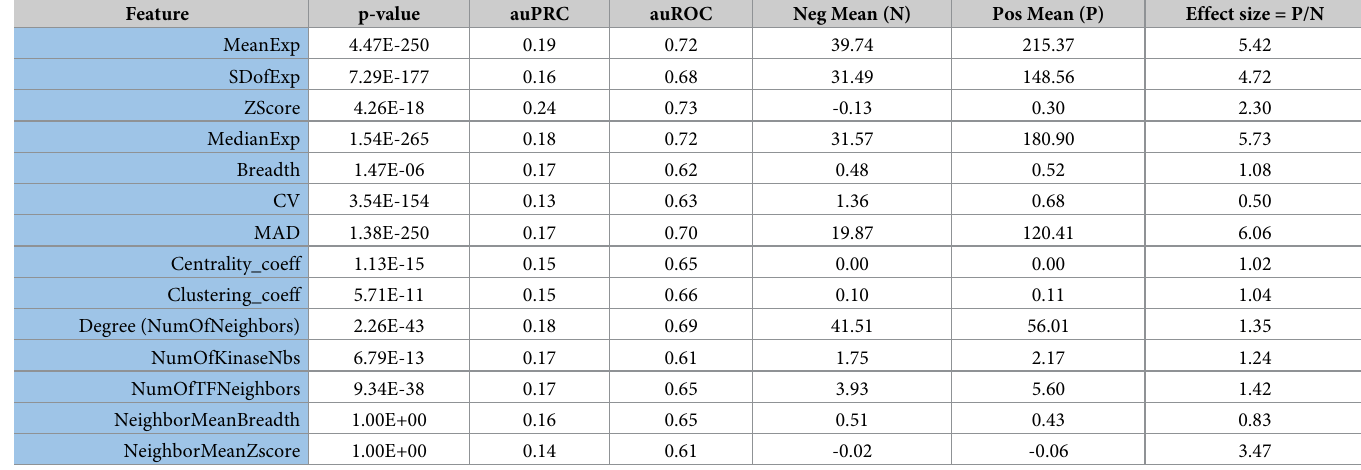
Table 1. Biological features and their potential to discriminate positive and background gene-tissue pairs. P-value: Wilcoxon test significance comparing the feature values for the positive and the negative gene-tissue pairs. auROC: Area under the receiver operating characteristic curve. auPRC: Area under the precision recall curve. Feature